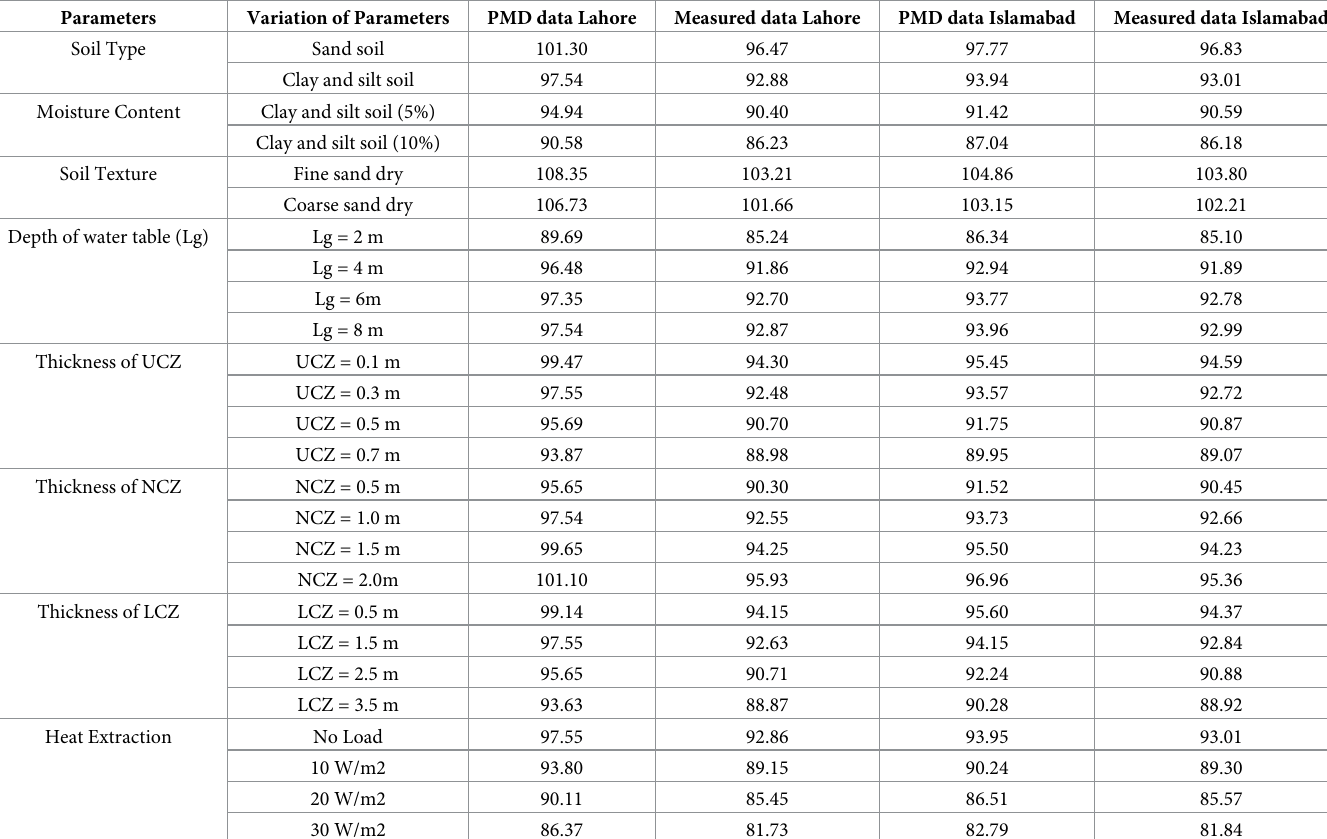
Table 2. Results summary for maximum LCZ temperature under different climatic and soil